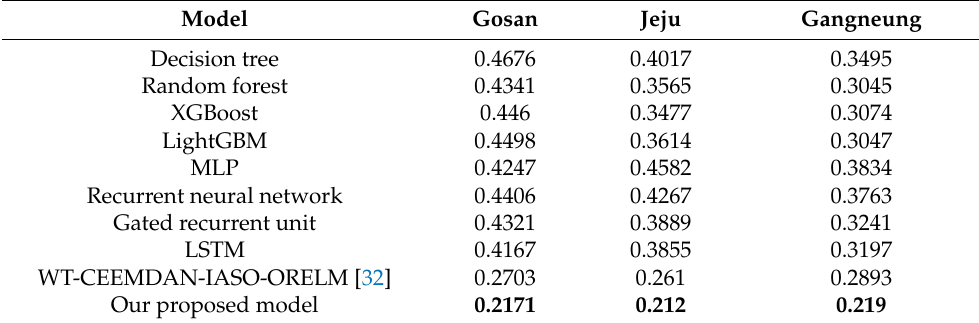
Table 7. MAE results of solar radiation forecasting models in three regions (MJ/m 2